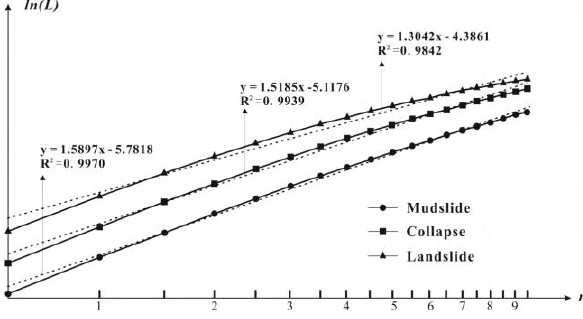
Figure 1. Fractal analysis of density of geological